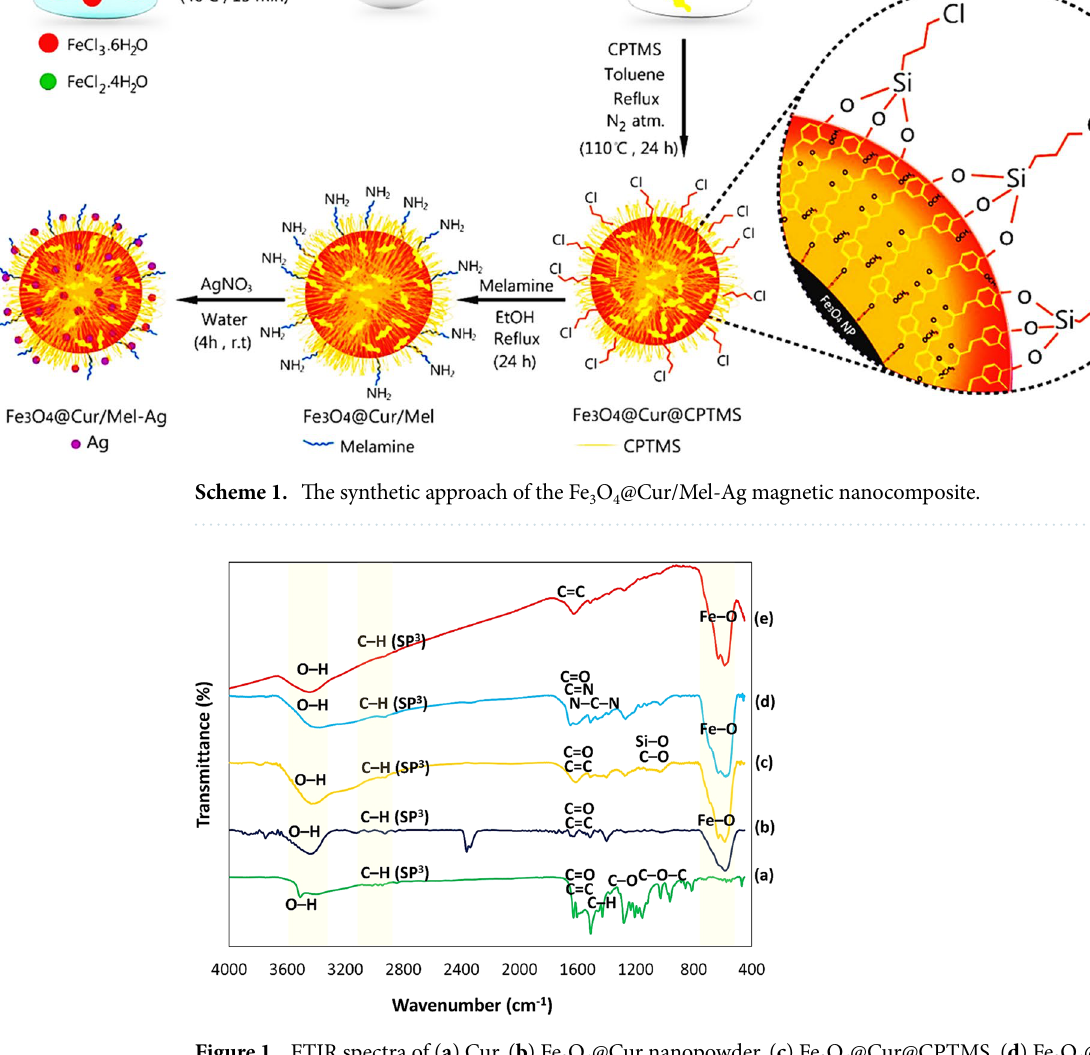
Figure 1. FTIR spectra of ( a ) Cur, ( b ) Fe 3 O 4 @Cur nanopowder, ( c ) Fe 3 O 4 @Cur@CPTMS, ( d ) Fe 3 O 4 @Cur/Mel, ( e )